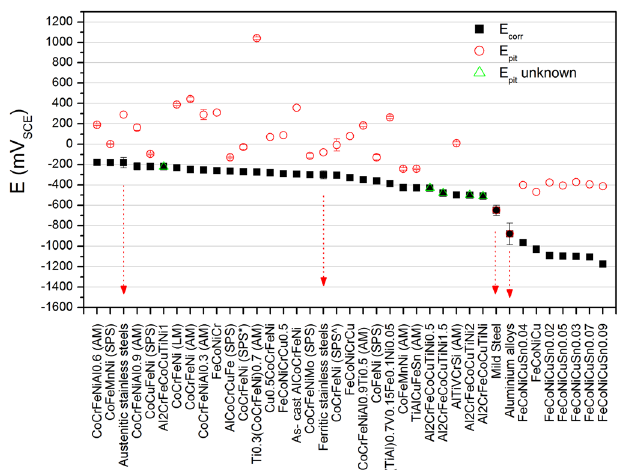
Fig. 16 A summary of the E corr and E pit values of different CCAs in quiescent 0.6 M NaCl at 25 °C. Here, LM denotes CCAs manufactured by laser melting (additive manufacturing/laser powder processing), AM denotes arc melting and SPS denotes spark plasma sintering. The alloy CoCrFeNi (SPS*) was produced by spark plasma sintering and held at 1000 °C for 5 min, while CoCrFeNi (SPS^) was fi rstly held at 500 °C for 5 min then sintered at 1000 °C for another 5 min. E corr and